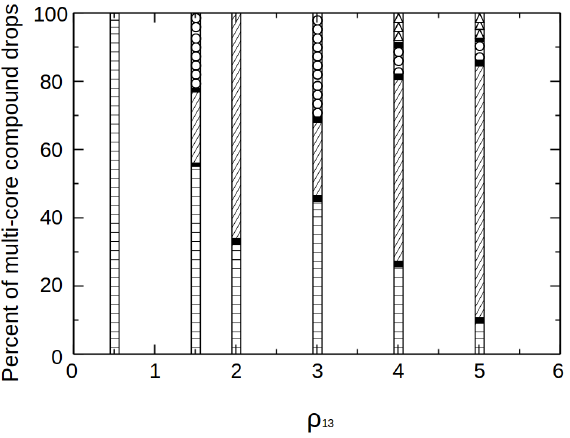
Figure 6. Percent of multi-core compound drops formed vs inner-to-outer density ratio. The horizontal and slant lines depicted in this plot correspond to 1-core and 2-core compound drops respectively whereas circles and triangles denote 3-core and 4-core compound drops formation